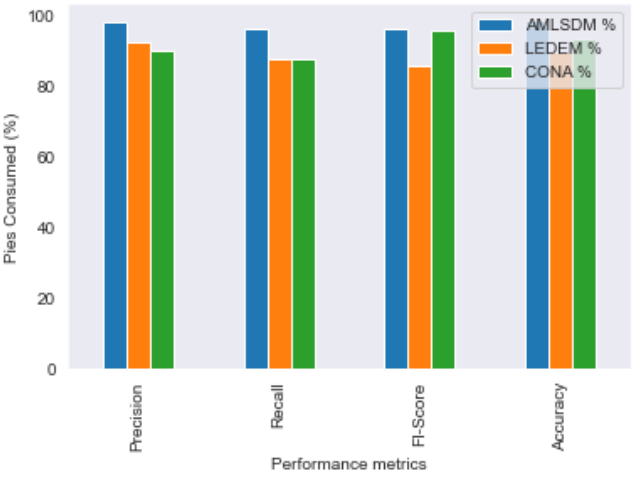
Figure 27. Performance comparison of AMLSDM with LEDEM and